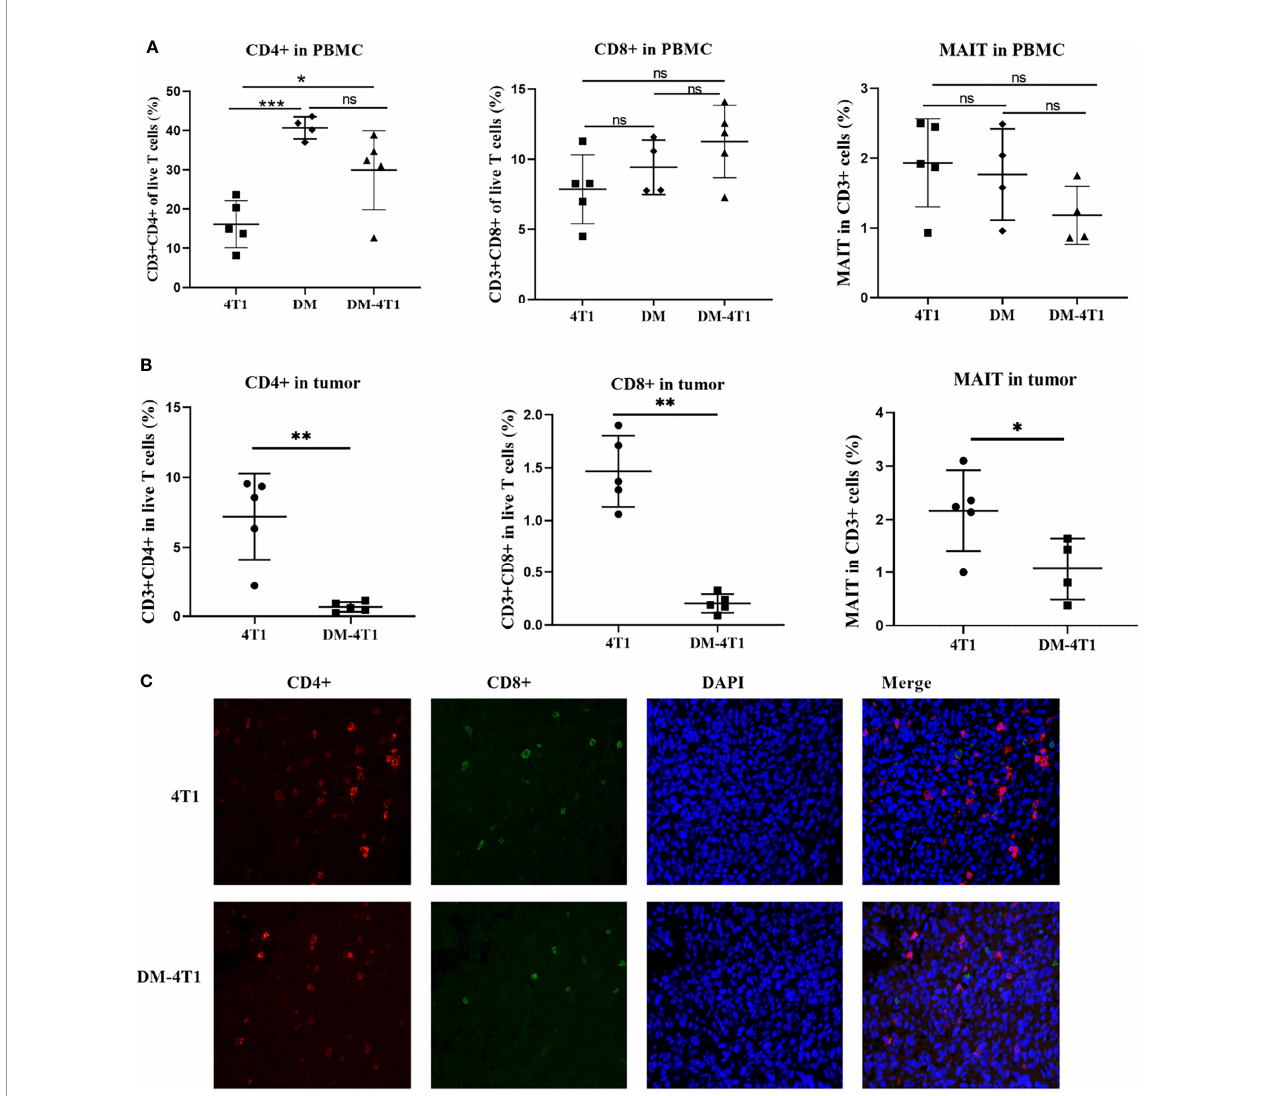
FIGURE 4 | The in fi ltration of CD8+ T, CD4+ T, and MAIT cells were decreased in DM-4T1 group compared with 4T1 group. (A, B) The levels of CD8+ T, CD4+ T, and MAIT cells in PBMC (A) and in tumor (B) were detected using FCM. (C) The distribution of CD4+ T cell (red) and CD8+ T cell (green) in tumor tissue was con fi rmed using indirect immuno fl uorescence (IF). ns, no signi fi cant difference, * p ≤ 0.05; ** p < 0.01;*** p <